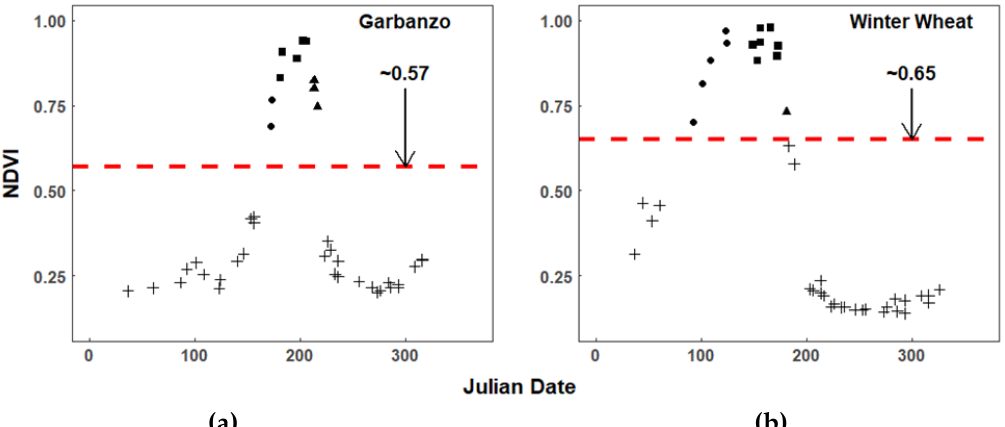
Figure 6. Temporal profile of normalized difference vegetation index (NDVI) for a garbanzo plot ( a ) and winter wheat plot ( b ) from 2016. The red dashed line indicates the average between maximum and minimum NDVI observed for each plot during 2016. The value is indicated in the plot. NDVI values are from pixels which passed the QA filter described in Section 2.2.